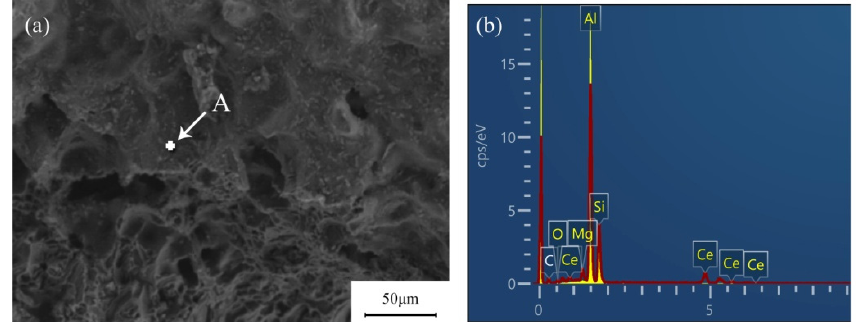
Figure 19. SEM fractograph and EDS analysis of the (AlSiCe) intermetallic compound in the A357 modified alloy with 0.16% Ce. ( a ) Detecting position, ( b ) EDS analysis.